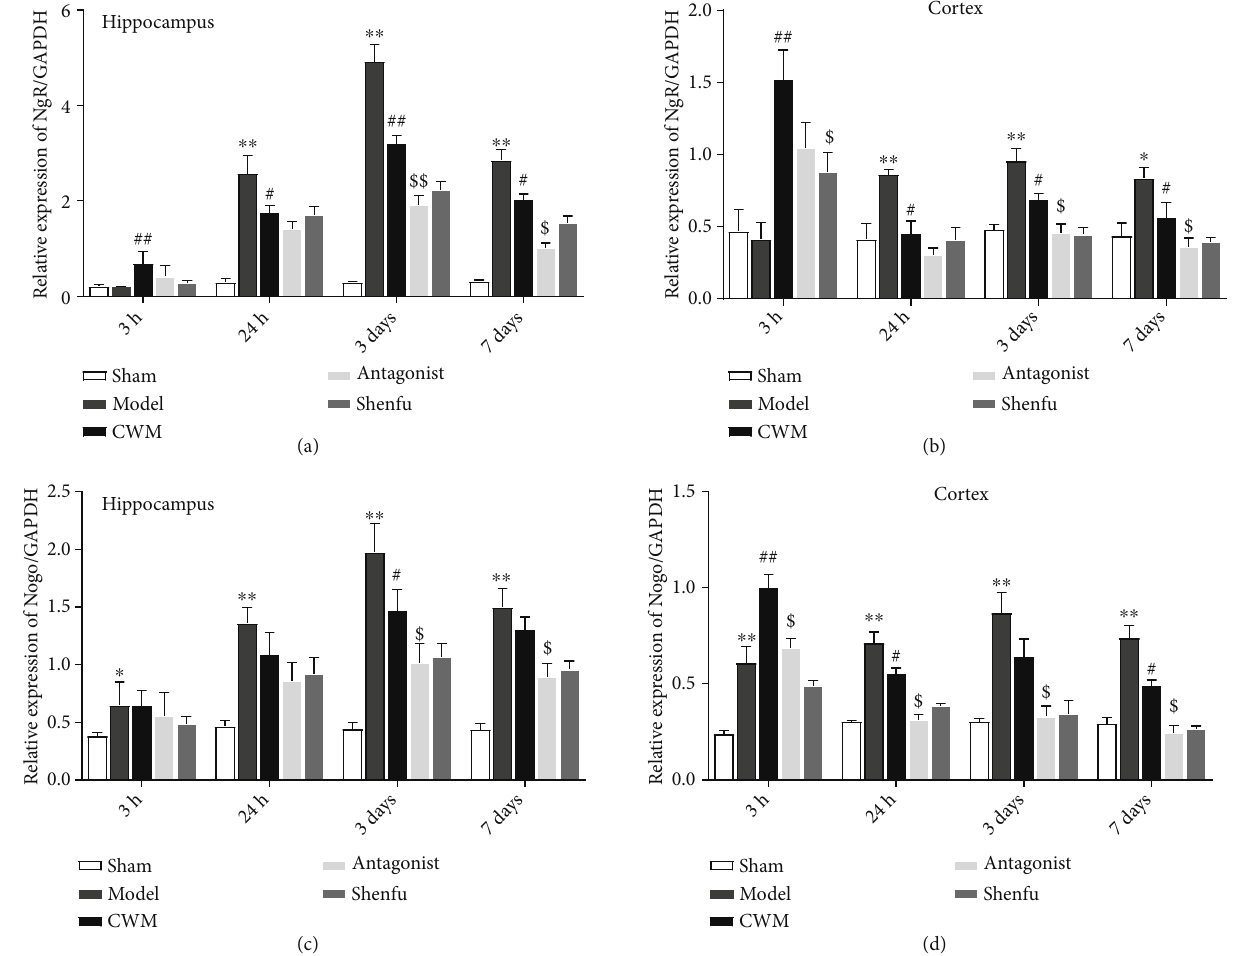
Figure 3: The relative messenger ribonucleic acid expression of Nogo and Nogo receptor in hippocampal tissues (a) and (c) and cerebral cortex tissues (b) and (d) at 3 hours, 24 hours, 3 days, and 7 days after return of spontaneous circulation (ROSC). Compared with the sham group, * P < 0 : 05 and ** P < 0 : 01 ; compared with the model, # P < 0 : 05 and ## P < 0 : 01 ; compared with the conventional western medicine, $ P < 0 : 05 and $$ P < 0 : 001 . n = 3 in each subgroup at di ff erent